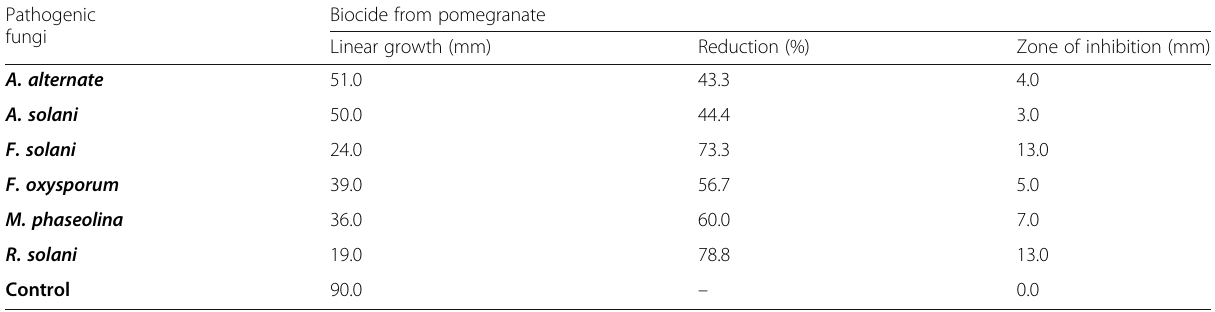
Table 2 In vitro antifungal activity of biocide from Pp on mycelial growth and zone of inhibition of some pathogenic fungi isolated from legume seeds